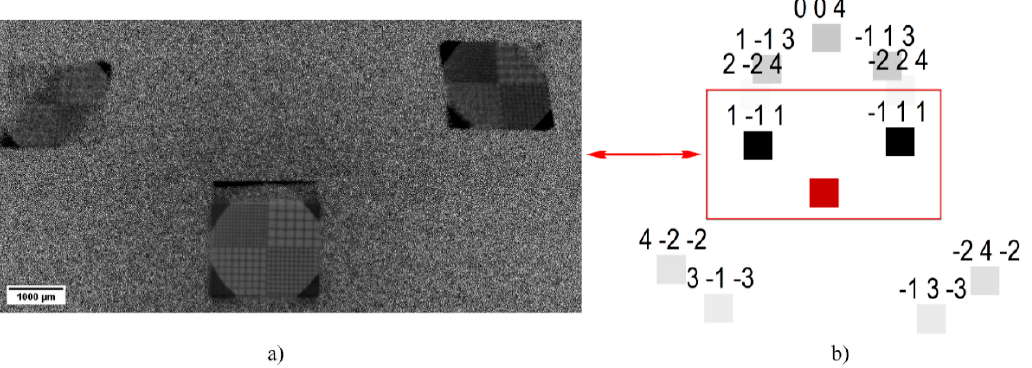
Figure 6. Image-type reflections: ( a ) with calibration grid for cases of the transmitted X-ray beam, the planes 111 and 111 correspond to the characteristic K α and K β lines of Mo accordingly; ( b ) theoretical simulation using LauePt software [21].